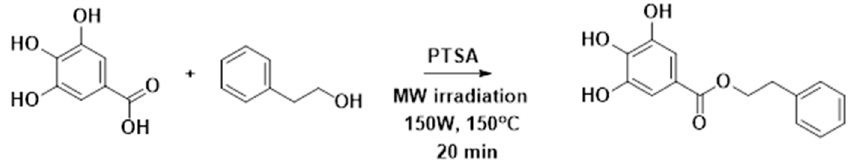
Figure 5. Synthetic procedure of PEGA.